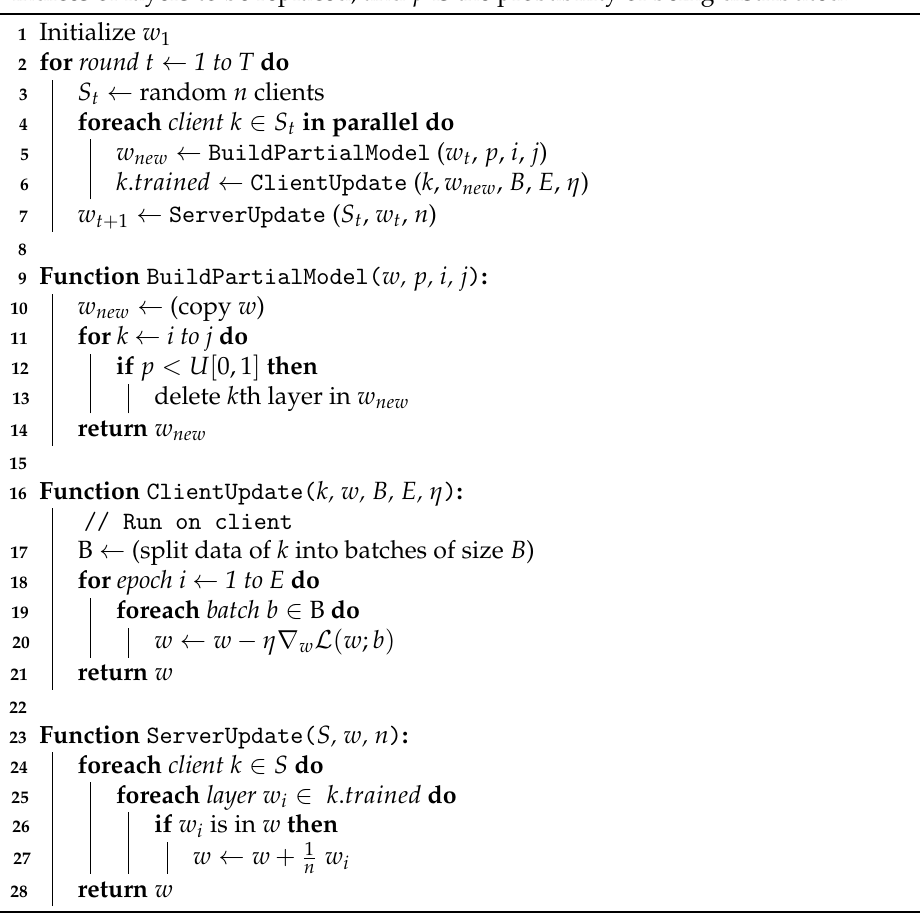
Algorithm 1: FederatedPartial. T is the number of communication rounds, B is